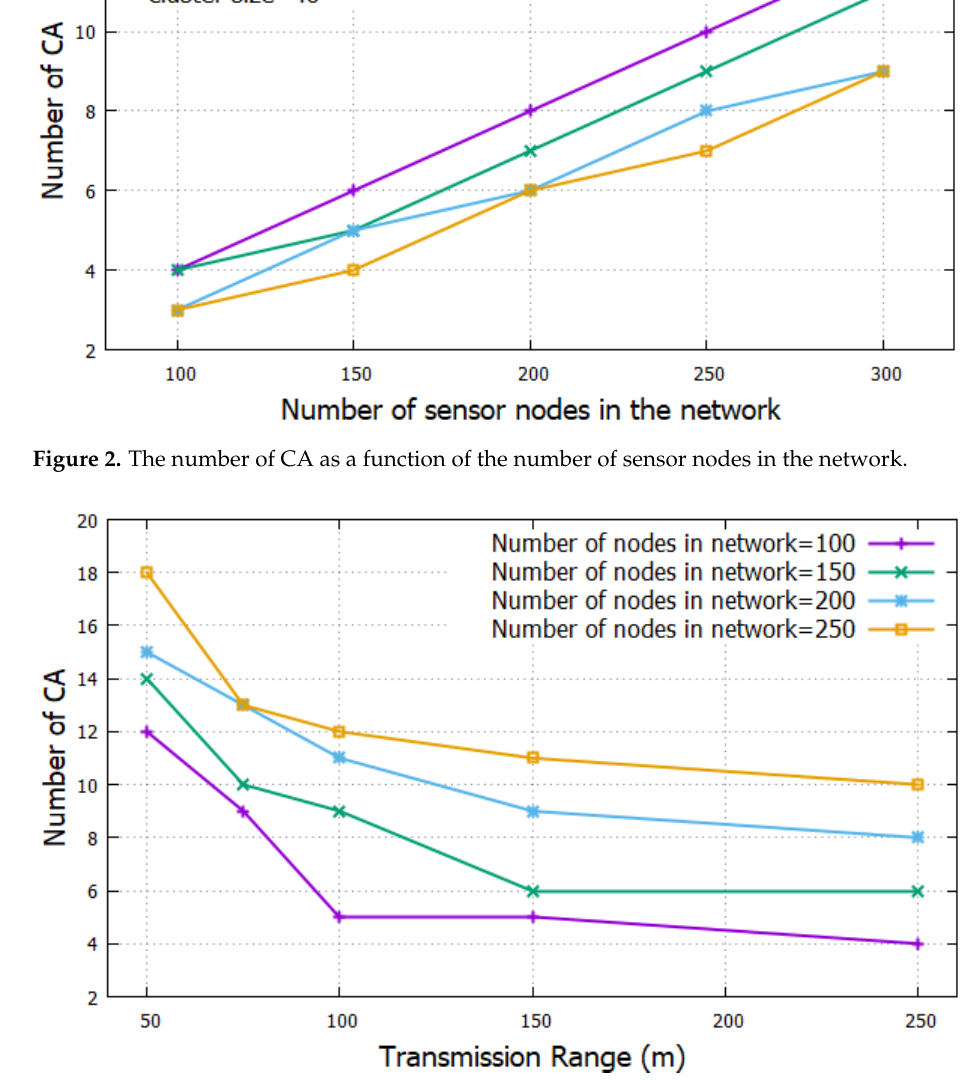
Figure 3. Number of CA as a function of the transmission range.